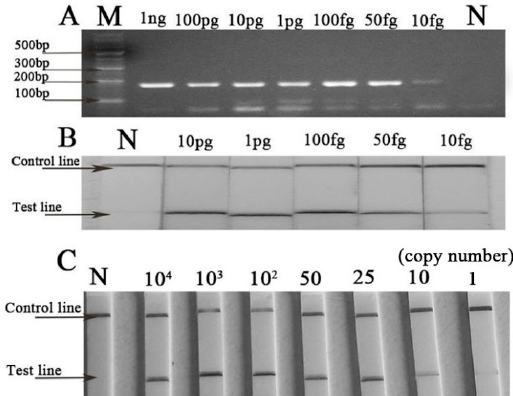
Figure 2. Detection of a series of diluted B. burgdorferi DNA by basic recombinase polymerase amplification (B-RPA) and LF-RPA. ( A ) The B-RPA results shown by agarose gel electrophoresis. M stands for marker, N stands for negative control (water); ( B ) The LF-RPA results shown by Hybridetect 2T dipsticks. N stands for negative control (water); ( C ) Detection of B. burgdorferi DNA from 10 4 copies to one copy by LF-RPA assay.